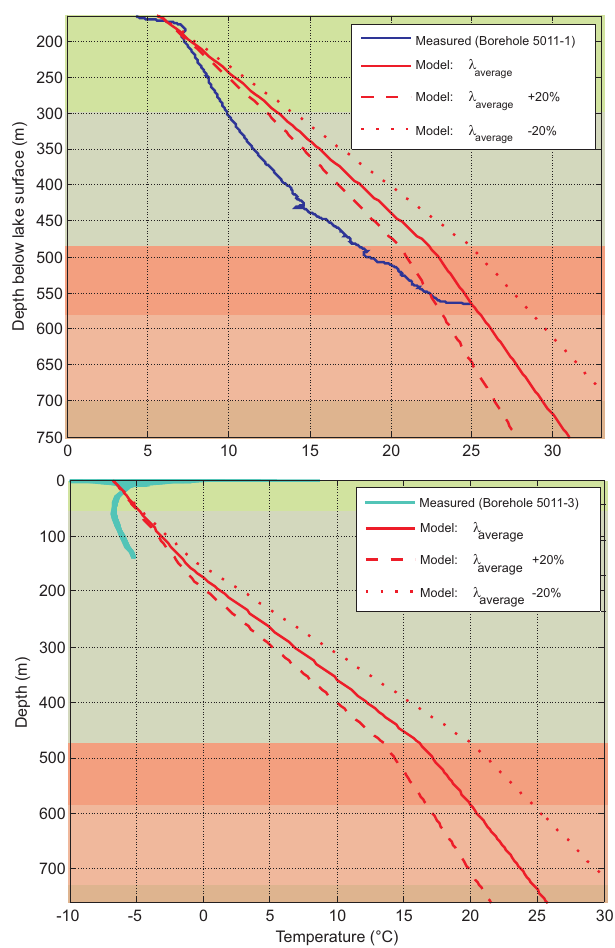
Fig. 5. Modelled temperatures at borehole locations 5011-1 and 5011-3. The dashed lines show the sensitivity to thermal conduc- tivity variations. The colours indicate the units as in Fig.